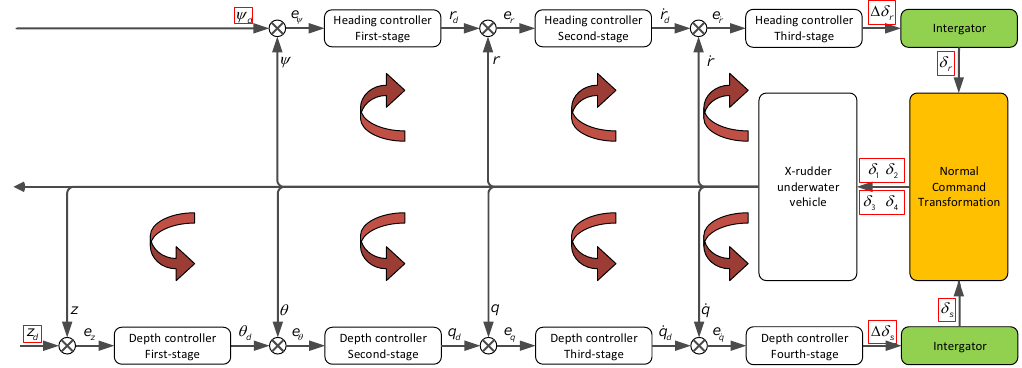
Figure 8. Principle diagram of DIFC. δ r and δ s are virtual vertical and horizontal rudder commands Figure 8 . Principle diagram of DIFC. r  and s  are virtual vertical and horizontal rudder commands respectively. ∆ δ is the increment, δ i ( i = 1,2,3,4 ) is the actuator’s control input. e ∗ represents the error. respectively.  is the increment,   1,2,3,4 i i   is the actuator’s control input. * e represents ψ is the heading angle, r is the yaw rate, . r is the yaw acceleration, z is the depth, θ is the pitch angle, q the error.  is the heading angle, r is the yaw rate, r is the yaw acceleration, z is the depth,  . q is the pitch is the pitch rate, and is the pitch angle, q is the pitch rate, and q is the pitch acceleration.